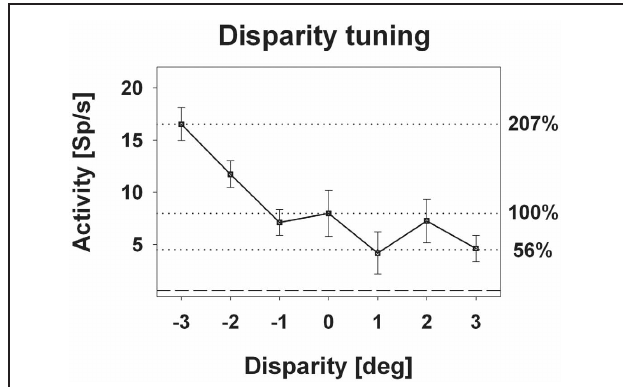
FIGURE 3 | Disparity tuning: single cell level. The diagram shows the disparity tuning of a representative neuron (mean discharge ± standard error). The horizontal dotted lines indicate the mean discharge for stimuli presented at screen distance, i.e., zero disparity, and those disparities evoking the maximum ( − 3 ◦ disparity) and the minimum ( + 1 ◦ disparity) response. Activity induced by stimuli at zero disparity was normalized to